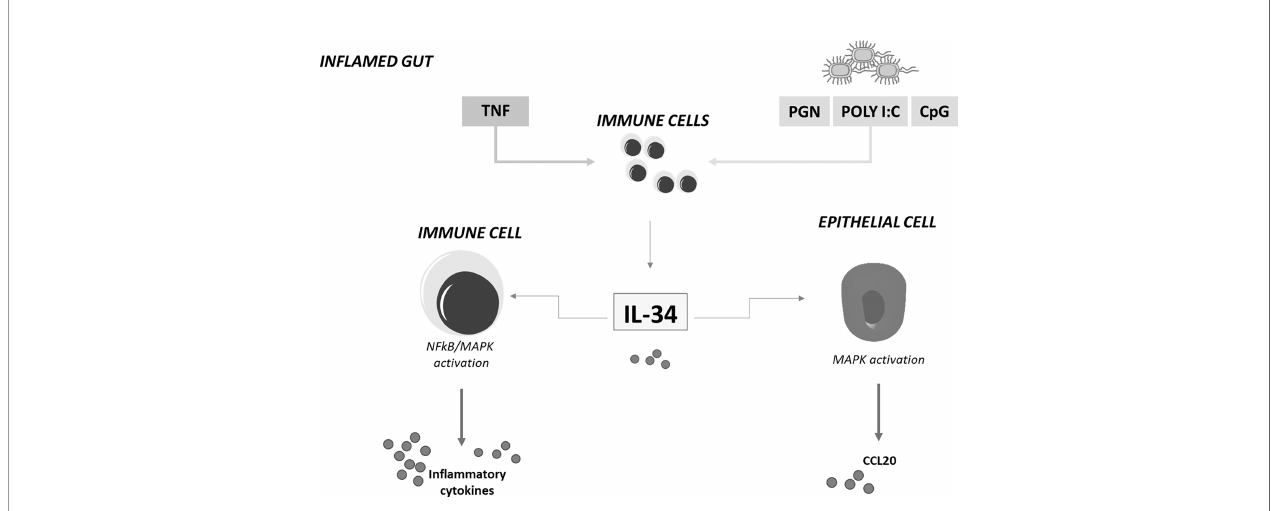
FIGURE 1 | IL-34 regulates in fl ammatory cytokine and chemokine production in in fl amed gut. IL-34 produced by lamina propria immune-in fl ammatory cells in response to TNF and toll-like-receptor stimulation stimulates immune cells to produce in fl ammatory cytokines and epithelial cells to secrete chemoattractants. MAPK, mitogen-activated protein kinase; NFkB, nuclear factor kappa-light-chain-enhancer of activated B cells; CCL20, chemokine (C-C motif) ligand 20; TNF, tumor necrosis factor; IL-34, interleukin-34; PGN, Peptidoglycan; CpG, 5'C-phosphate-G3'; Poly I:C, polyinosinic:polycytidylic